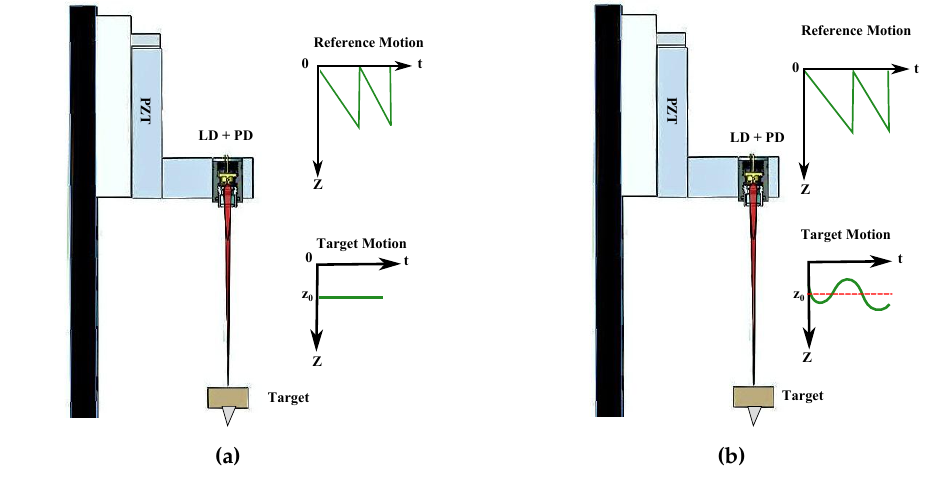
Figure 1. Example of a mechanically-modulated optical feedback interferometry (OFI) setup. ( a ) Reference signal acquired while the target is in a static position with respect to the Y axis; ( b ) The measurement signal is acquired while both the target and the PZT are in